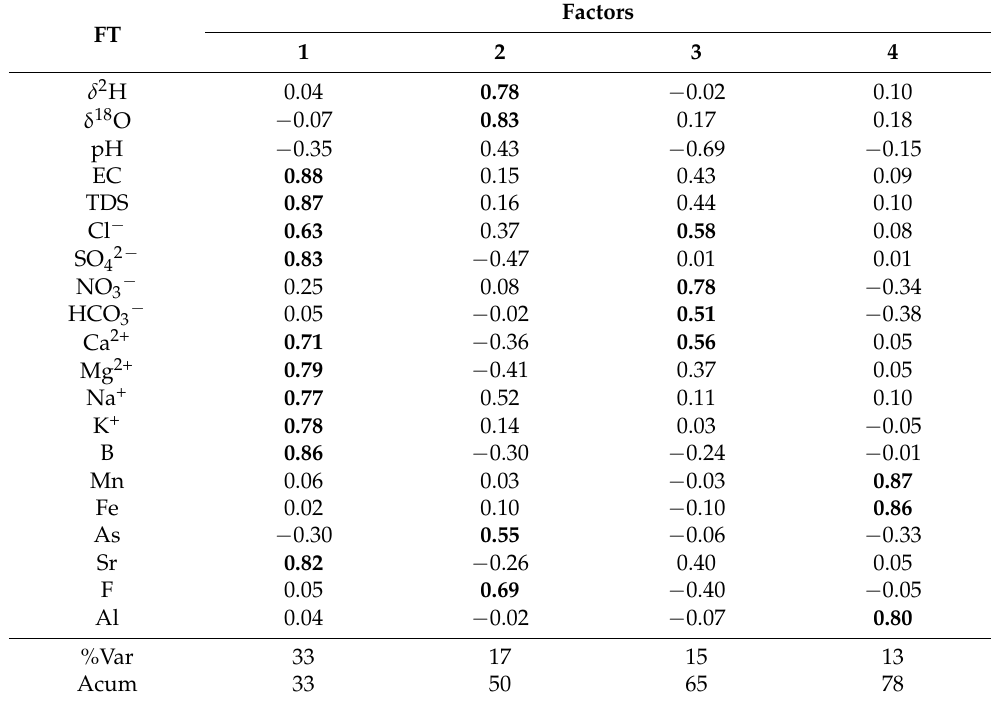
Table 3. Factors using main ions, trace elements, physical properties, and stable isotopes.